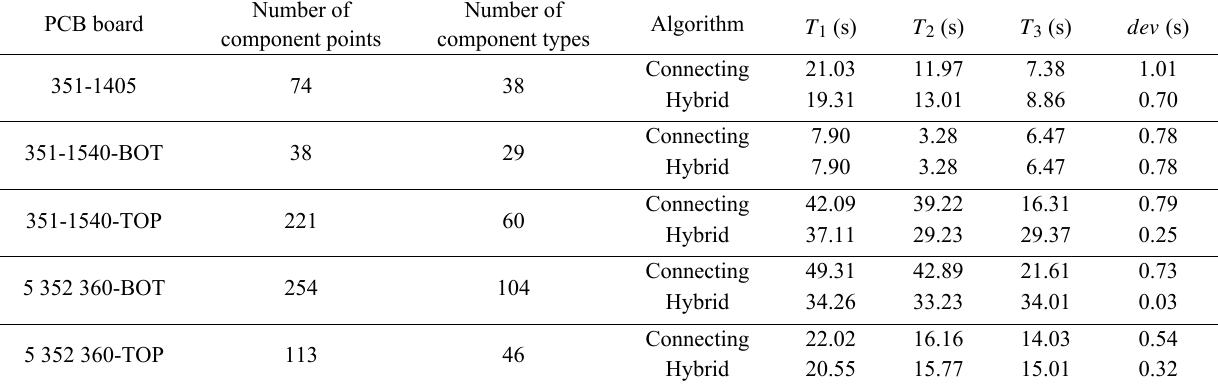
Table 2 Comparison of experimental results.